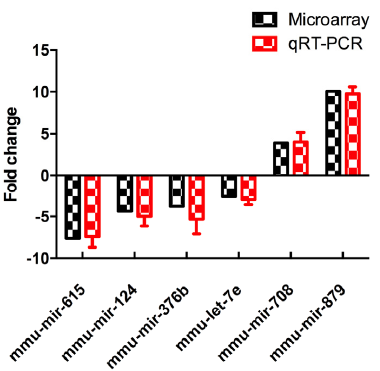
Figure 4. Differentially-expressed miRNAs were detected by miRNA array and validated by qRT-PCR. Data represented as the mean ± SEM ( n = 6 to 8, per group). The fold change was calculated